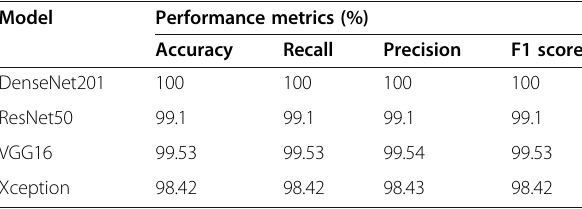
Table 1 The values of accuracy, recall, precision, and f1-score were obtained for the pre-trained models